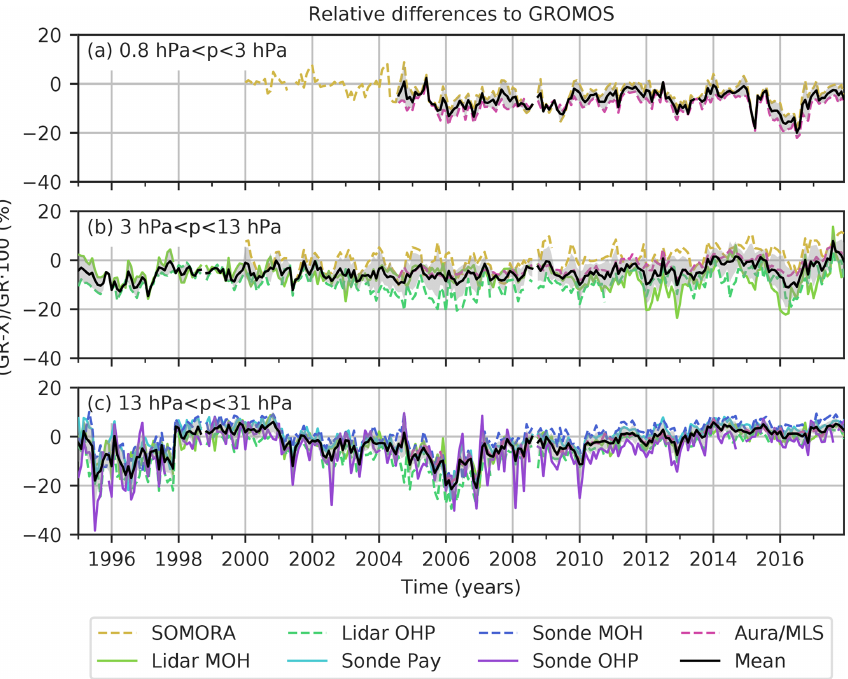
Figure 3. Relative differences (RD) of monthly means between GROMOS and coincident pairs of SOMORA, lidars (MOH, OHP), ozoneson- des (Payerne, MOH, OHP), and Aura/MLS, averaged over three altitude ranges. The relative difference (RD) is given by ( GR − X)/ GR · 100, where GR represents GROMOS monthly means and X represents monthly means of the other data sets. The black lines show the mean values of all RDs, and the grey shaded areas show its standard